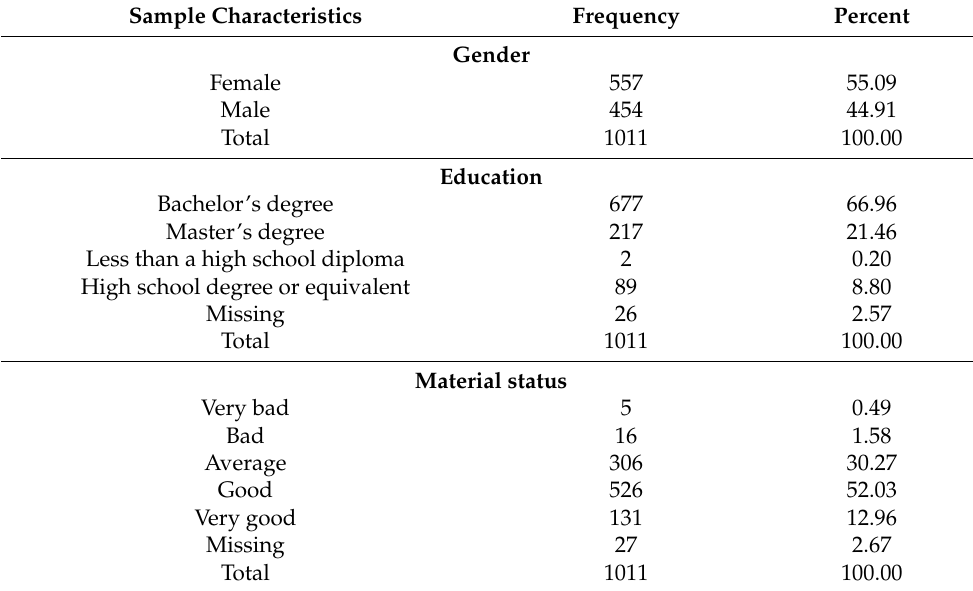
Table 1. Characteristics of the respondents ( N =